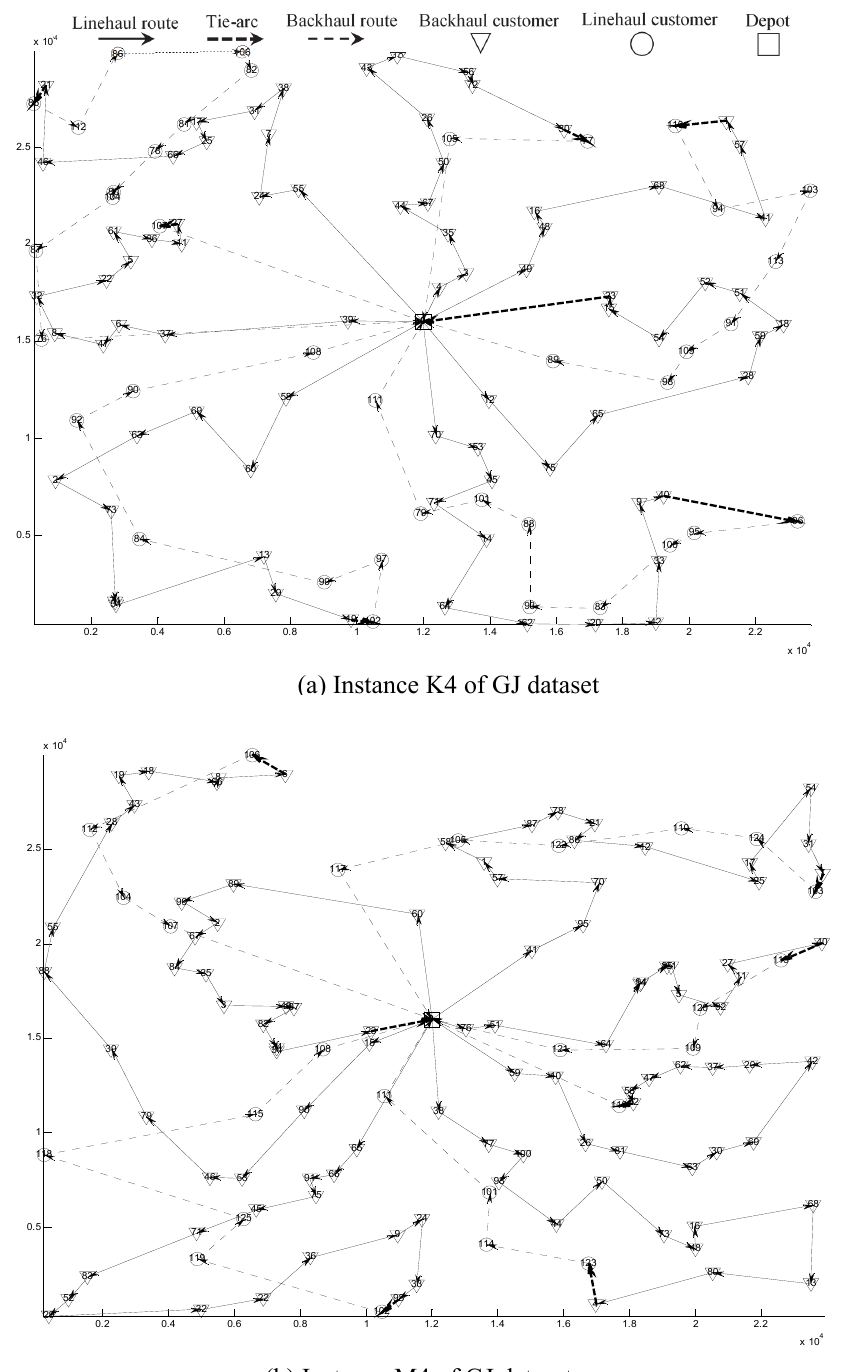
Fig. 3. Examples of VRPB optimal